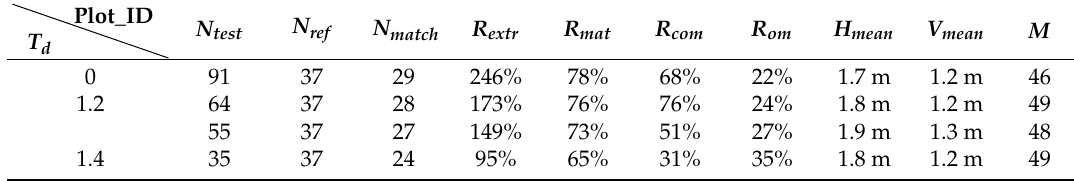
Figure 11. Matching results of 4-N GOC and LM + filtering methods.